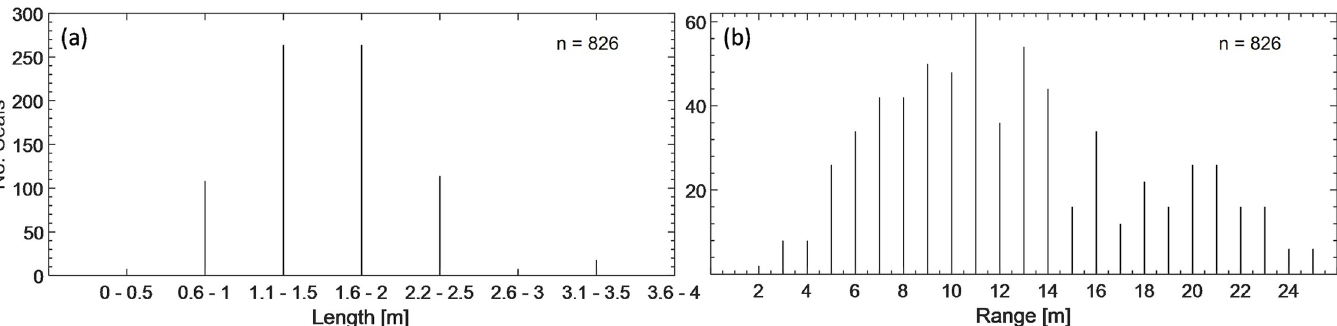
Fig 7. Distribution of occurrence of seals in relation to (a) length and (b) detection range. Seals measuring 1.1 m to 2 m were the most frequent and were mostly detected within 6 m to 16 m of range.